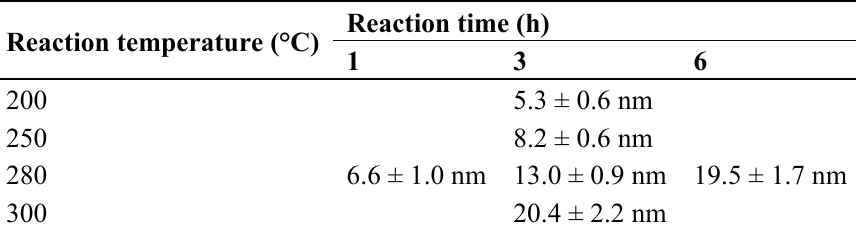
Table 1. Summary of the relationship between the reaction conditions and the particle sizes of the resulting